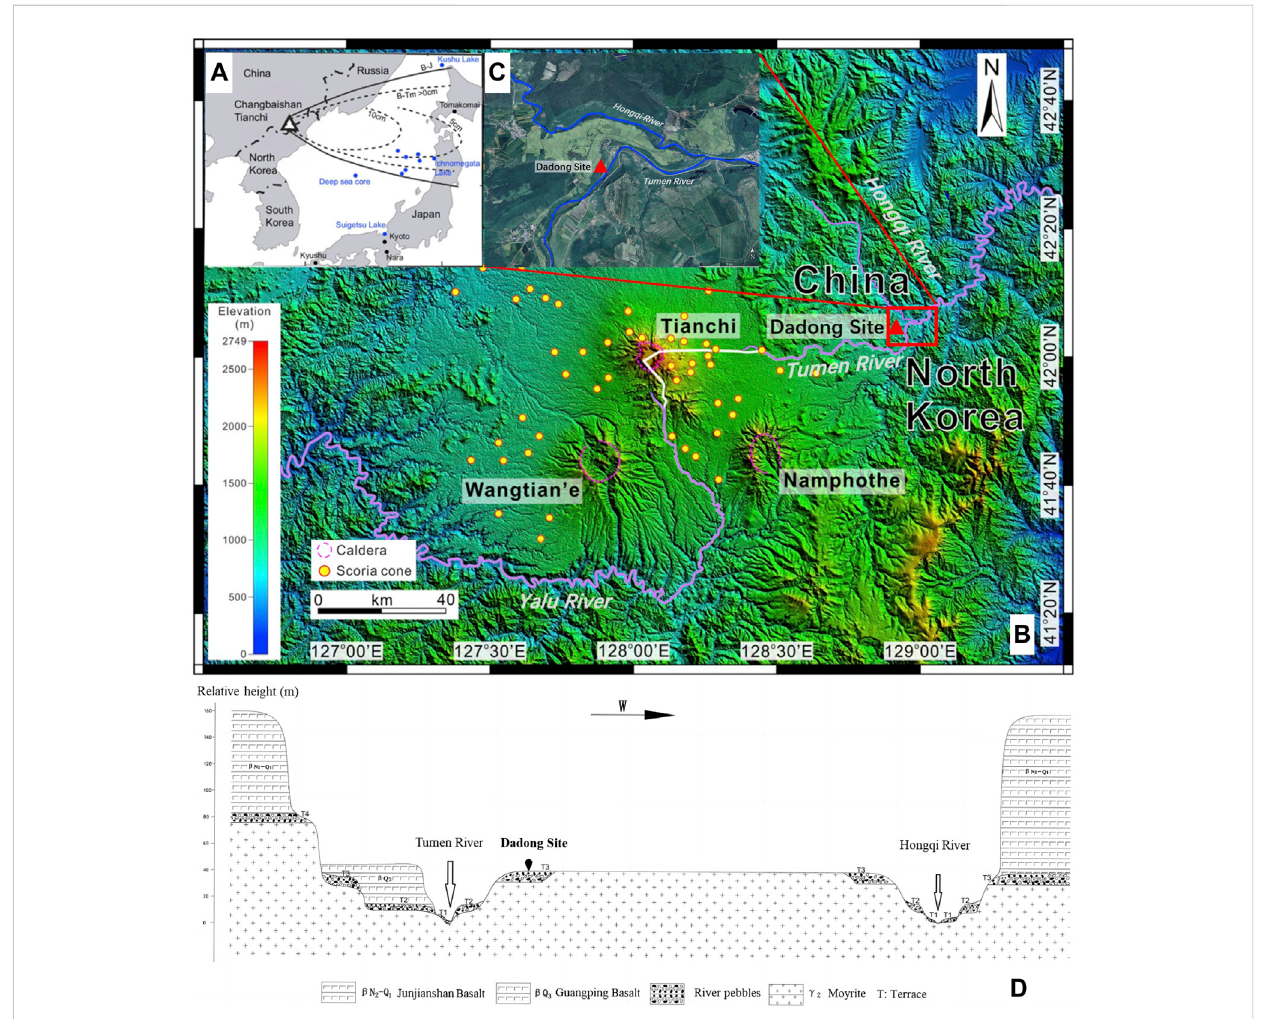
FIGURE 1 Geographic map around the Dadong site: (A) The location of Tianchi volcano and the extents of ashfalls of Baegdusan-Tomakomai tephra (B-Tm) and Baegdusan-Japan Sea tephra (B-J), photo adapted from Pan et al., 2020; (B) DEM map showing distribution of polygenetic volcanoes and representative monogenetic volcanoes around the Dadong site. The thick solid white line and the Tumen and Yulu Rivers are the border between China andNorthKorea.Photomodi fi edfromZhangetal.,2018; (C) EnlargedmapshowingthedetailedlocationoftheDadongSite(modi fi edfromGoogle Maps); (D) Schematic diagram showing the geomorphology of the Dadong